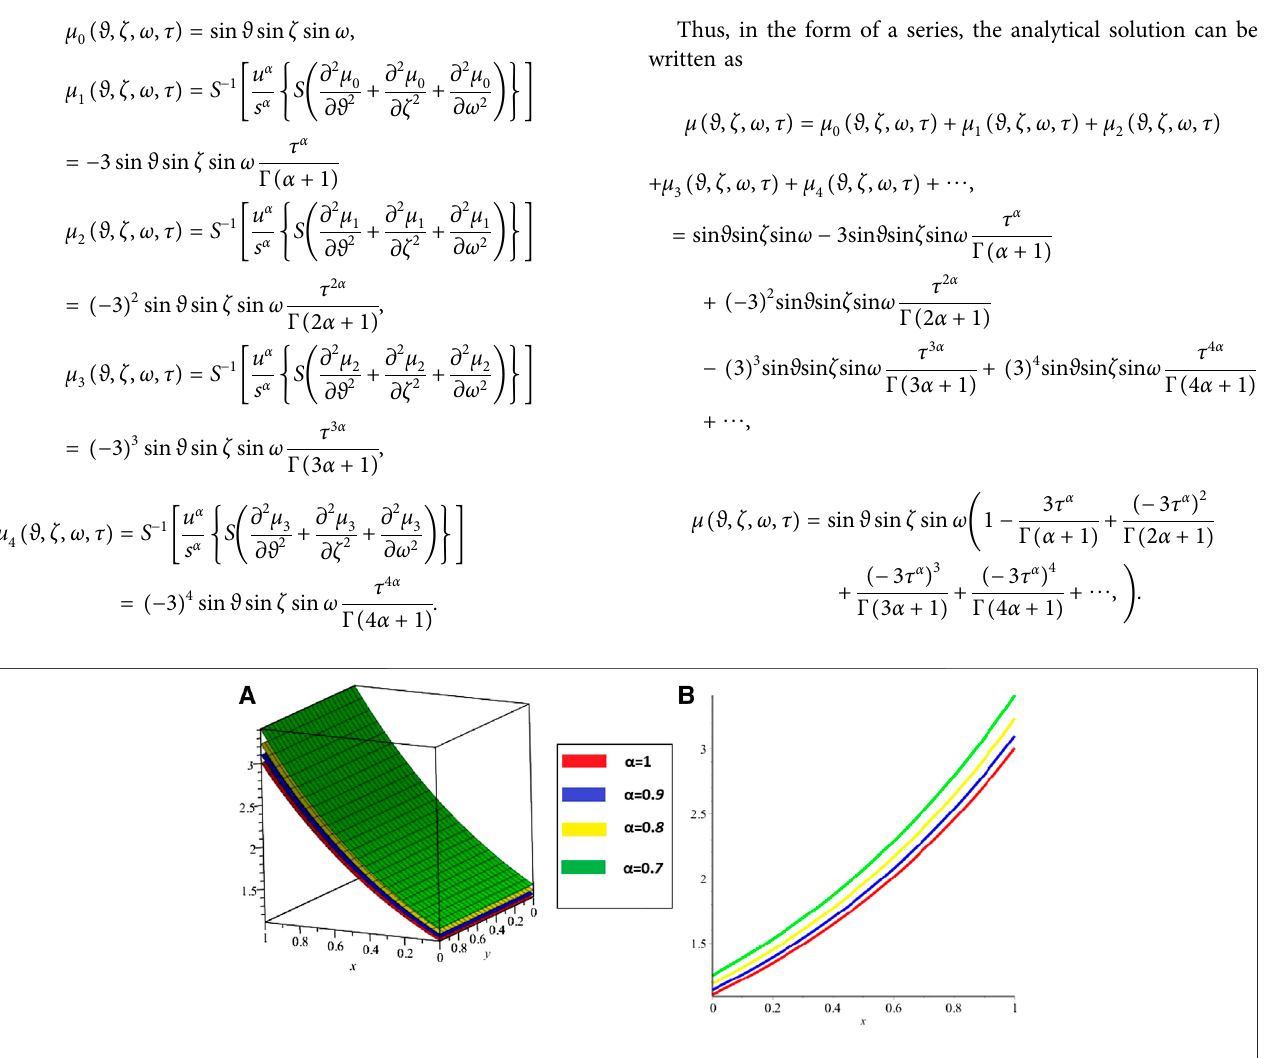
FIGURE 2 | ISTM solution of example 1 (C) at various fractional-order α (D) the fractional-order solutions at ξ (cid:2) 0 . 5. In Figure 2 , the ISTM solutions at different valuesof α arepresented.Thesub-graphs (C) and (D) represents 3Dand 2Dplotsoffractional ordersolutionsofExample 1.Theconvergence ofthefractional solutions towards integer solutions is